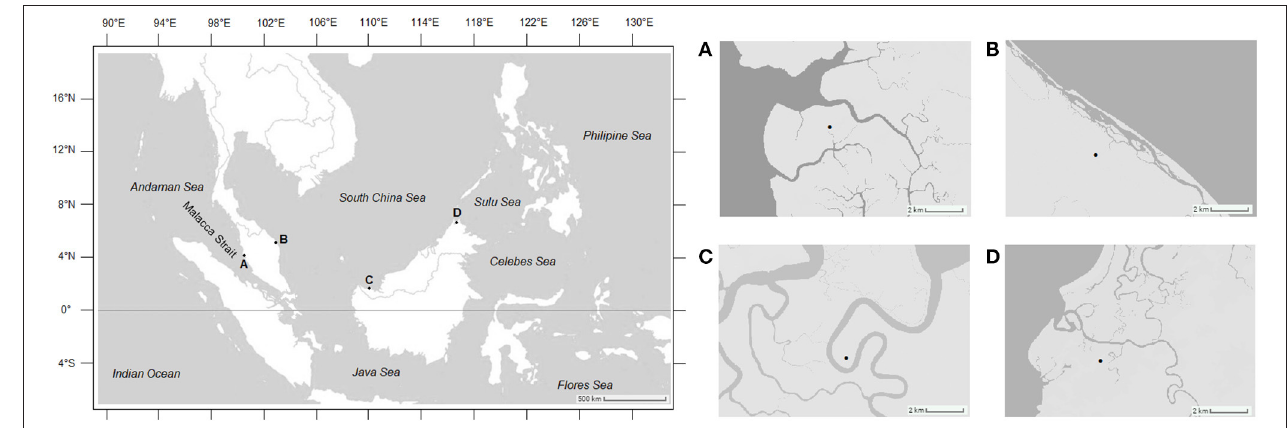
FIGURE 1 | Mud crab sampling locations of this study. (A) Matang Mangrove Forest Reserve, Perak; (B) Setiu Wetlands, Terengganu; (C) Asajaya mangrove forest, Sarawak; (D) Kota Marudu mangrove forest,